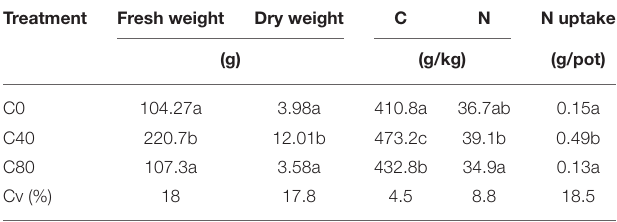
TABLE 3 | Effect of compost on yield, nutrient composition and N uptake in lettuce*. Treatment